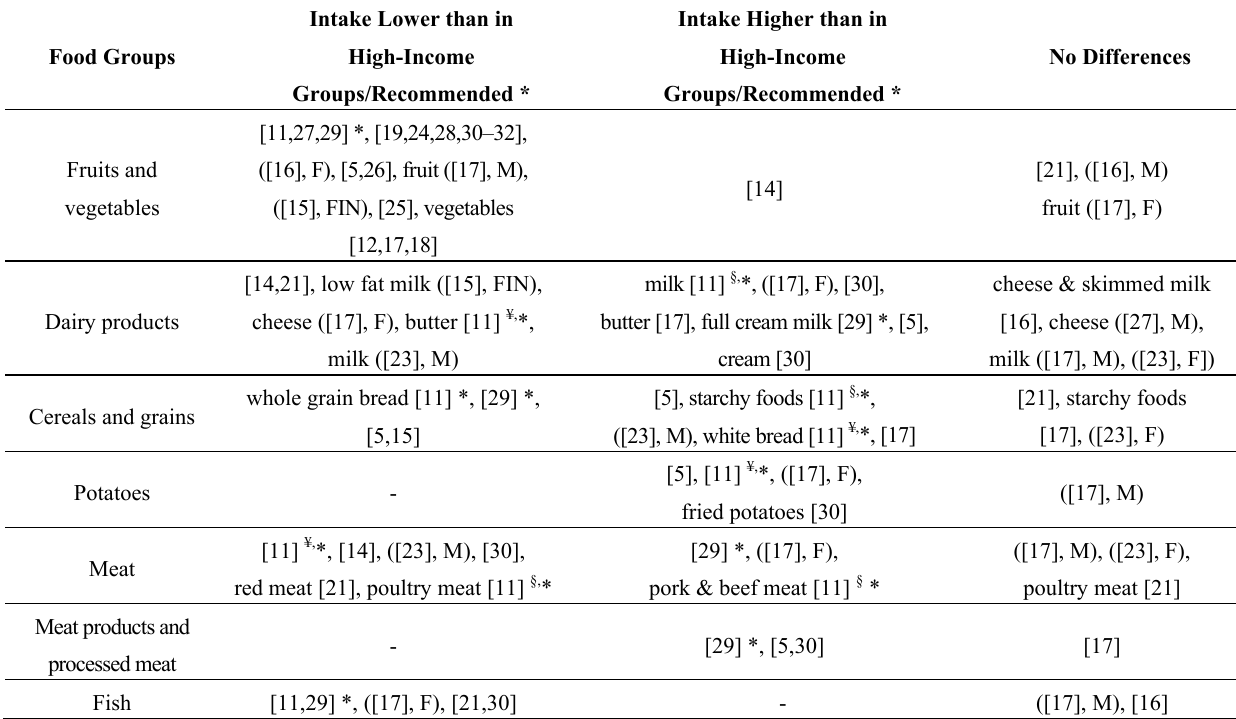
Table 2. A summary of reported findings on food intake among low-income populations from the included